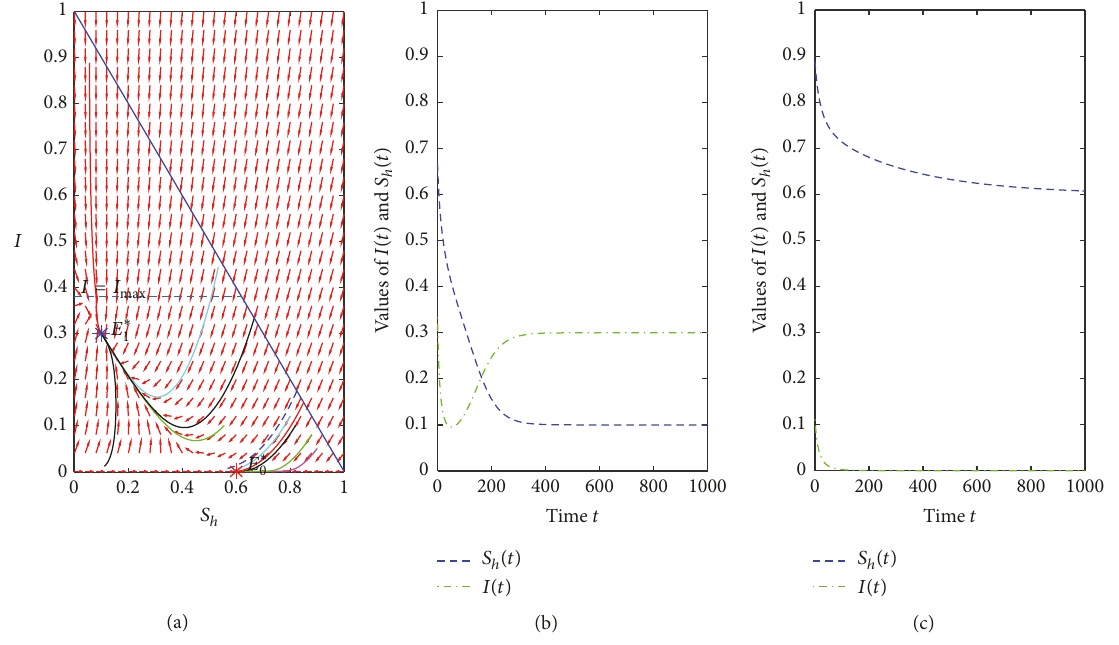
Figure 3: Trajectory figure and time plots of Example 1.